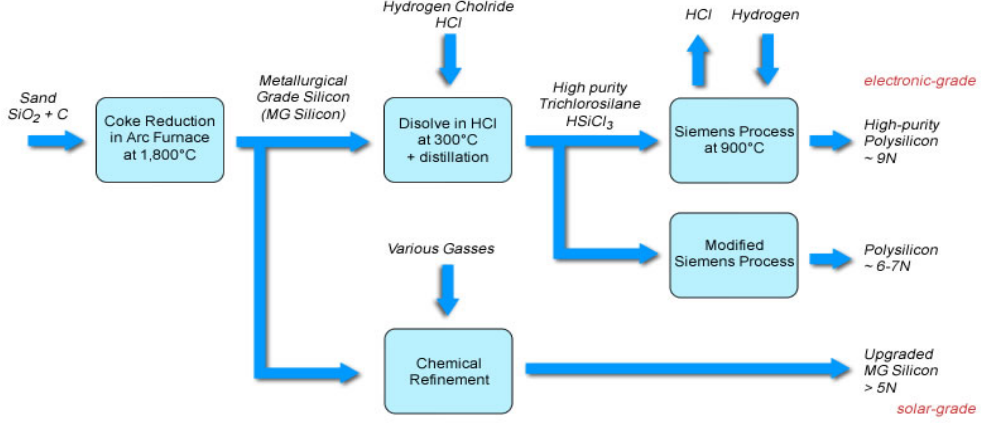
Fig. 1. Making silicon for solar